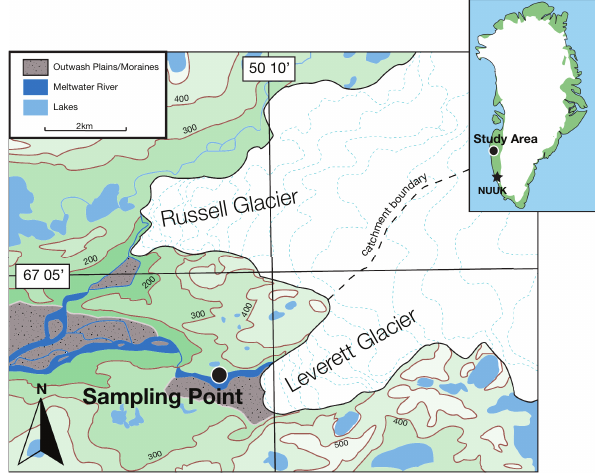
Figure 1. Map of the terminus of Leverett Glacier (sampling lo- cation is noted) and context within the wider Greenland Ice Sheet. Contour elevations are shown in metres and land-use type is denoted (white corresponds to the ice sheet); from Hawkings et al.